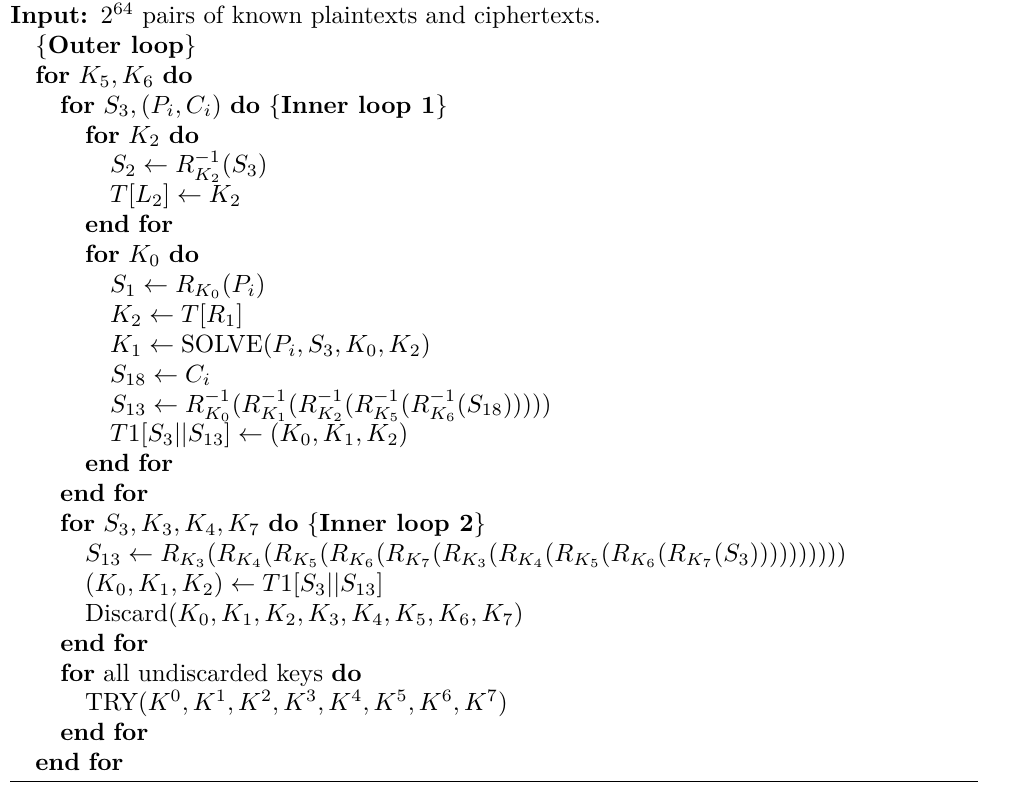
Algorithm 2 Pseudocode of the improved impossible reflection attack against